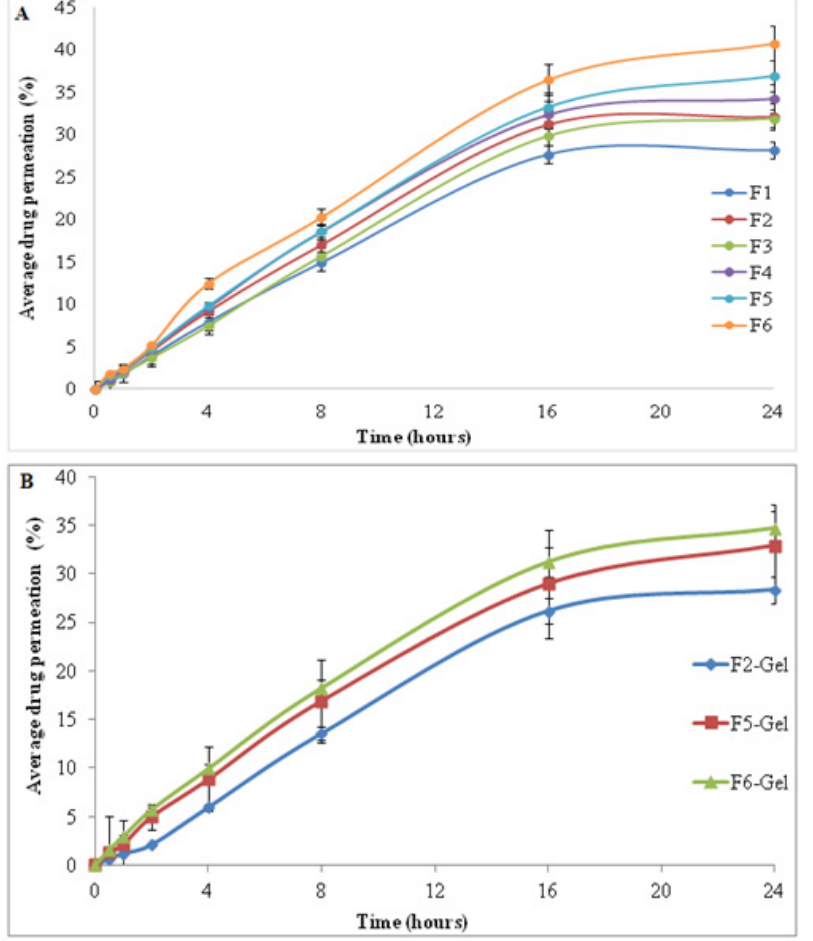
Figure 4. Permeation of drug through the skin from ( A ) SLNs formulation and ( B ) SLN-loaded gel .